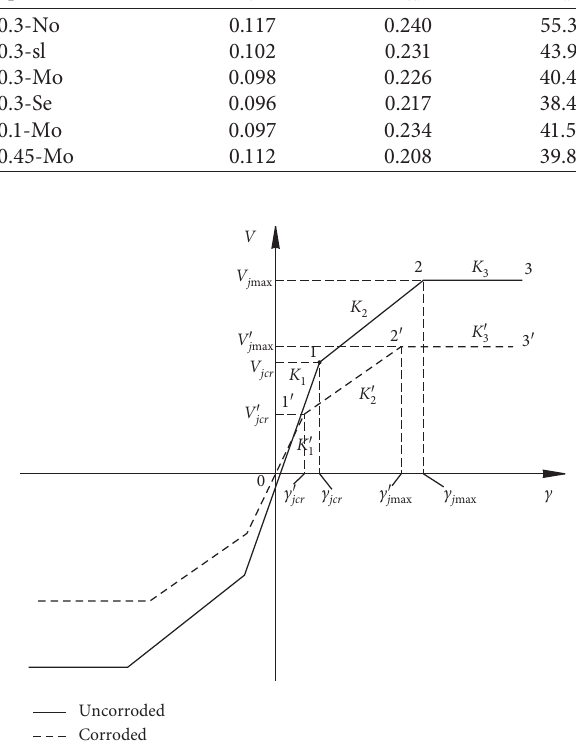
Figure 10: Backbone curves of restoring force model of specimens with and without being